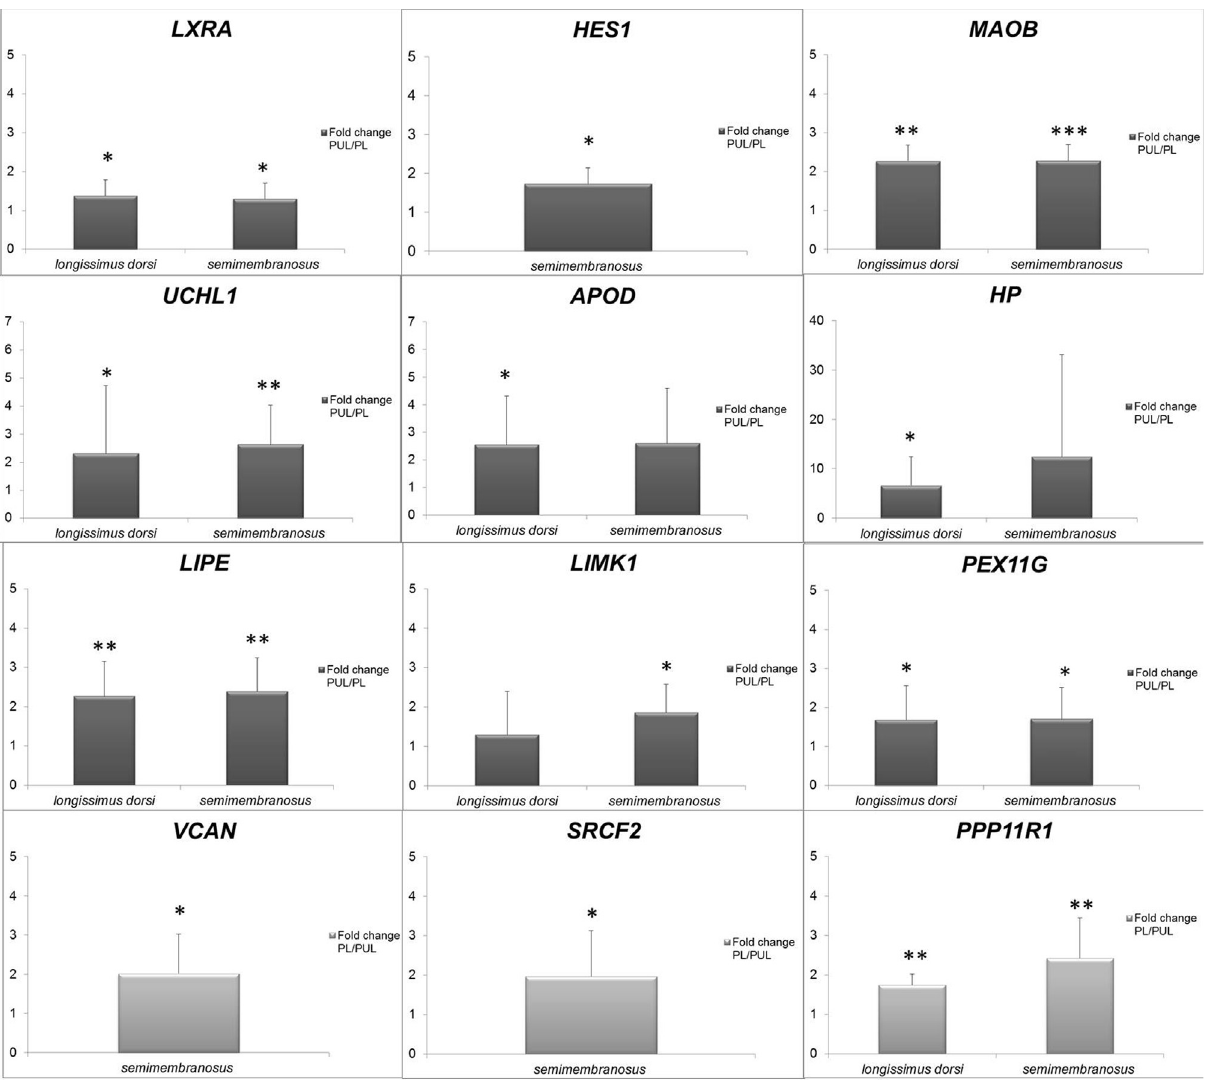
Figure 1 - Relative quantity of mRNA shown as fold change values between analyzed pig muscles ( semimembranosus and longissimus dorsi ). The brighter bars show FC values based on the PL pig group as reference and the darker bars show FC values with PUL as reference. The genes of interest were normalized by two endogenous control genes, OAZ1 and RPL27. * P (cid:4) 0.05, ** P (cid:4) 0.01, *** P (cid:4)